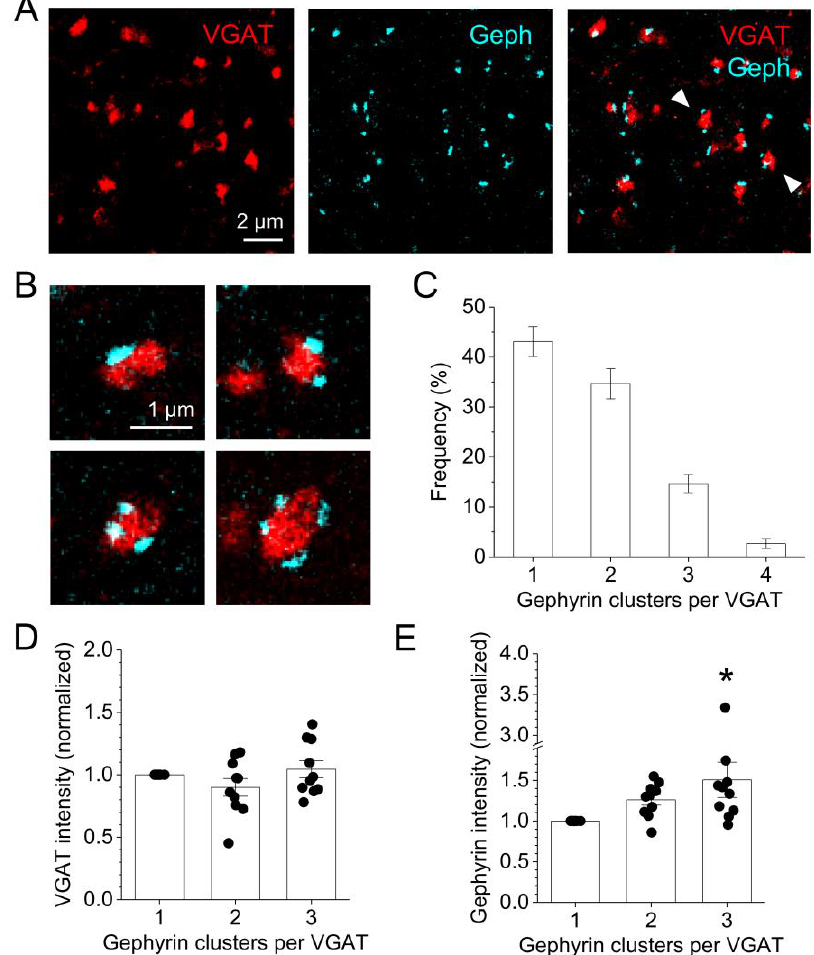
Figure 2. Single GABAergic presynaptic terminals have multiple postsynaptic contacts. ( A ) Ex- ample of post-expansion VGAT (left panel, red) and gephyrin (middle panel, cyan) immunolabeling. Right panel: overlay of VGAT and gephyrin reveals VGAT clusters surrounded by multiple gephyrin clusters (arrowheads). ( B ) Examples of VGAT clusters in contact with 1, 2, 3 or 4 gephyrin clusters. ( C ) Distribution of gephyrin cluster numbers per VGAT (total n = 225 VGAT clusters in the territory of 15 astrocytes from 5 independent experiments and 3 animals). ( D ) Analysis of integrated VGAT cluster fluorescence intensity contacting 1, 2, or 3 gephyrin clusters. Integrated VGAT fluo- rescence intensity was normalized per astrocyte to the value obtained for 1 gephyrin cluster (total n = 104 VGAT clusters in 10 astrocyte territories from 4 independent experiments). One-way ANOVA: p = 0.198. ( E ) Analysis of integrated gephyrin fluorescence intensity as in ( D ) (same data set). One- way ANOVA: p = 0.036. Tukey post hoc tests: 1 vs. 3 gephyrin clusters p = 0.028, p > 0.30 otherwise (without outlier near asterisk ANOVA p = 0.00225 and post hoc Tukey 1 vs. 3 clusters p = 0.00374). VGAT clusters contacted by 4 gephyrin clusters were not analyzed in ( D ) and ( E ) because there were too few per astrocyte territory for statistical analysis.